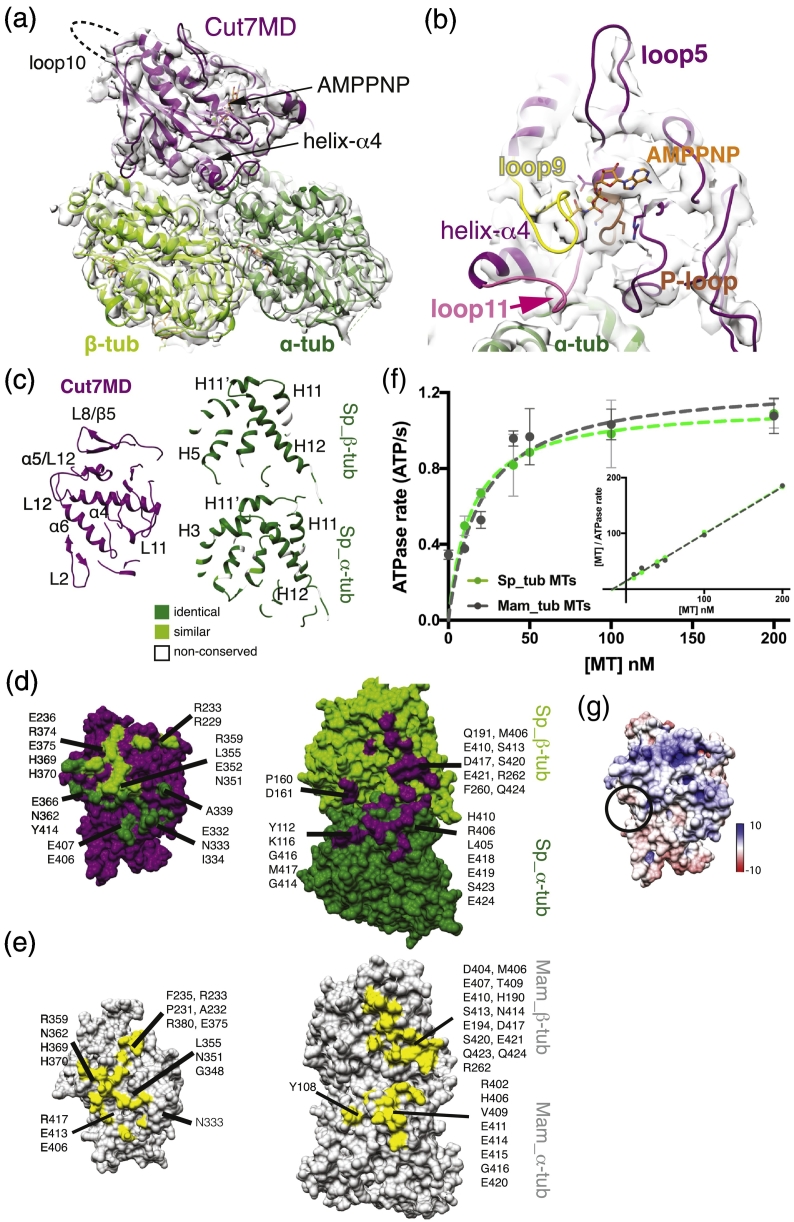
The 4.5 A resolution reconstruction of S. pombe Cut7MD-AMPPNP bound to Sp_tub MT reveals the distinct footprint of Cut7 on Sp_tub MTs. (a) The asymmetric unit (αβ-tubulin + Cut7MD) of the reconstruction viewed toward the nucleotide binding pocket with the Cut7MD homology model and Sp_tub atomic model docked into the density. The position of the disordered loop 10 is indicated by the dotted line. (b) View of the Cut7MD nucleotide binding pocket showing helix-α4 at the MT surface, the conserved nucleotide coordinating loops, P-loop (brown), loop9 (yellow) and loop11 (pink), as well as loop5 (purple) emerging away from the nucleotide binding site. The pink arrow indicates the separation of density corresponding to loop11 and the MT surface. (c) Ribbon depiction of longitudinal slices through the Cut7MD model (left) and Sp_tub αβ-tubulin (right) showing the structural elements involved in binding between motor and MT track. The αβ-tubulin ribbon is colored according to sequence conservation with mammalian tubulin; note, while loop2 (L2) lies close to the MT surface, there is no evidence in the EM density of a direct connection between this loop and the MT. (d) View of the MT binding surface of Cut7MD (left) and view of the Cut7MD binding surface of Sp_tub αβ-tubulin (right) with residues < 4 Å distant from each binding partner labeled and colored green and purple, respectively. This interface was evaluated using the model coordinates. (e) View of the MT binding surface of Cut7MD (left) and view of the Cut7MD binding surface of Mam_tub αβ-tubulin (right) with residues < 4 Å distant from each binding partner labeled and colored yellow, respectively. As above, this interface was evaluated using the model coordinates. (f) Cut7MD steady-state ATPase rate as a function of [MT] for Sp_tub (green) and Mam_tub (gray). Data were fit to a Michaelis–Menten kinetic yielding values for Cut7MD Vmax and K0.5MT, respectively, of 1.14 ± 0.02 ATP/s and 13.9 ± 1.1 nM on Sp_tub MTs (R2 = 0.990) and 1.25 ± 0.1 ATP/s and 19.9 ± 5.8 nM on Mam_tub MTs (R2 = 0.918), differences that are not statistically significant (p > 0.99). Inset, the same data presented as Hanes–Woolf plot, yielding values for Cut7MD Vmax = 1.17 ± 0.06 ATP/s and K0.5MT = 13.4 ± 1.1 nM on Sp_tub MTs (R2 of fit = 0.999) and 1.19 ± 0.20 ATP/s and K0.5MT = 14.3 ± 3.4 nM on Mam_tub MTs (R2 = 0.993), which are not statistically significantly different (p > 0.99). (g) Cut7MD MT binding interface colored by surface charge. The approximate position of the adjacent negatively charged β-tubulin C-terminal tail is marked by a circle. A recombinant His6-tagged Cut7 monomeric construct, residues 67–432 lacking its N-terminal extension (Cut7MD) in a pET151D-TOPO vector (Invitrogen), was expressed in BL21*(DE3) E. coli cells as previously described [6]. In brief, cells were grown in LB medium, supplemented with 2% (w/vol) glucose with induction of protein expression by 0.5 IPTG at 18 °C for 5 h. Cells were resuspended in lysis buffer [50 mM Tris–HCl (pH 8.0), 400 mM NaCl, 1 mM MgCl2, 1 mM ATP, 5 mM 2-mercaptoethanol, 10% (vol/vol) glycerol and EDTA-free Protease Inhibitor Cocktail (Roche), 50 μM PMSF] and lysed using a French press. His6-tagged Cut7MD was purified from the clarified cell supernatant using nickel affinity chromatography, and the His6 tag was removed using TEV protease during overnight dialysis into 50 mM Tris–HCl (pH 8.0), 400 mM NaCl, 1 mM MgCl2, 1 mM ATP, 5 mM 2-mercaptoethanol and 10% (vol/vol) glycerol). Immediately prior to use, Cut7MD was buffer exchanged into BrB25 + [25 mM Pipes–KOH (pH 6.8), 30 mM NaCl, 0.5 mM EGTA, 5 mM MgCl2, 1 mM 2-mercaptoethanol, 5 mM AMPPNP] using a Vivaspin® column (Sartorius). To measure the Cut7MD ATPase activity, S. pombe MTs were assembled and stabilized by the addition of epothilone as for cryo-EM sample preparation, except that monomeric Mal3 was excluded from the polymerization mix. Mam_tub MTs were polymerized for 1 h at 37 °C, as previously described [20] using bovine tubulin (Cytoskeleton Inc., Denver, CO) and stabilized by the addition of 1 mM paclitaxel (Calbiochem). Cut7MD ATPase activity was measured using an enzyme-coupled assay [45] in a buffer consisting of 50 mM Tris (pH 8.0), 50 mM NaCl, 1 mM MgCl2, 0.5 mM phosphoenolpyruvate, 0.25 mM NADH, ~ 10 U/ml pyruvate kinase and ~ 14 U/ml lactate dehydrogenase and 5 mM ATP (all reagents from Sigma). The reactions, with each condition performed with 4–6 replicates, were initiated by the addition of Cut7MD at a final concentration of 1.5 μM. Activity was measured by the decrease in NADH absorbance at 340 nm for 10 min at 32 °C in a SpectraMax Plus 384 Microplate Reader (Molecular Devices).